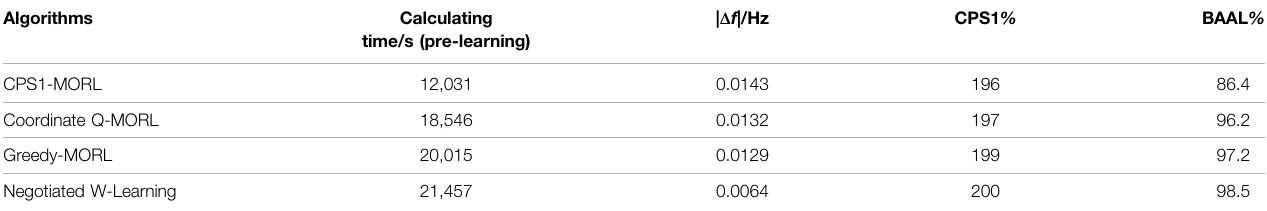
TABLE 1 | Simulation results under different